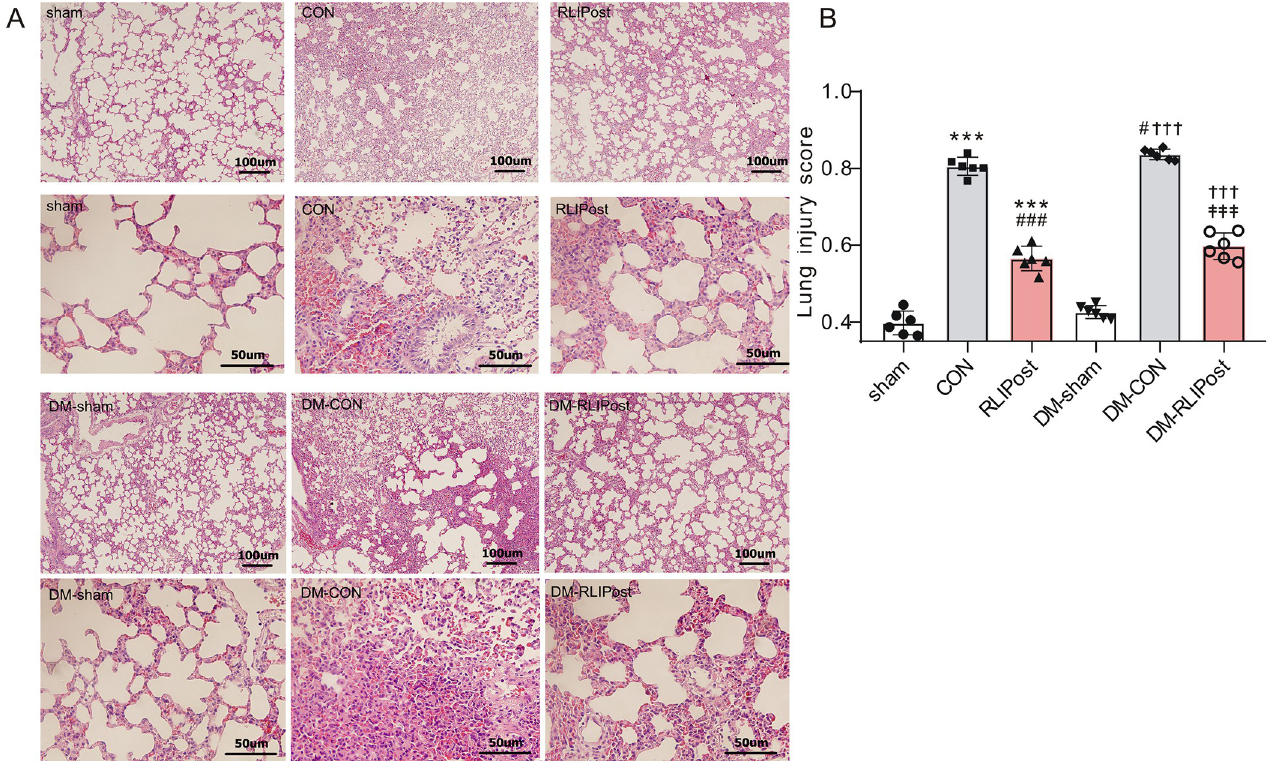
Fig 5. RLIPost preserves pulmonary histological structures post I/R. A. Representative photographs showing H&E-stained lung sections post I/R. sham: sham-operated, CON: control, RLIPost: remote liver ischemia postconditioning, DM: STZ-induced diabetes. B. Histological evaluation of pulmonary damage after reperfusion in experimental groups. n = 4–6 in each group. The severity of lung damage was graded (see the ‘Methods‘ section). Values are mean ± SD. ��� P < 0.001, versus the sham group, # P < 0.05, ### P < 0.001 versus the CON group, ††† P < 0.001 versus DM-sham, ‡‡‡ : P < 0.001 vs. DM-CON.